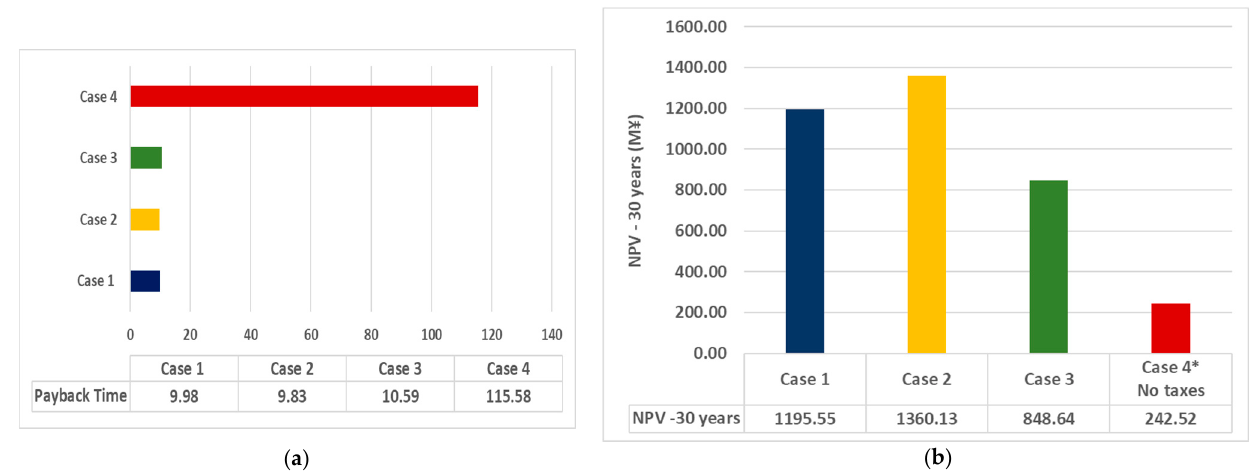
Figure 10. Influence of Solar Energy and Plastic Usage: ( a ) Payback time analysis; ( b ) net present value analysis.